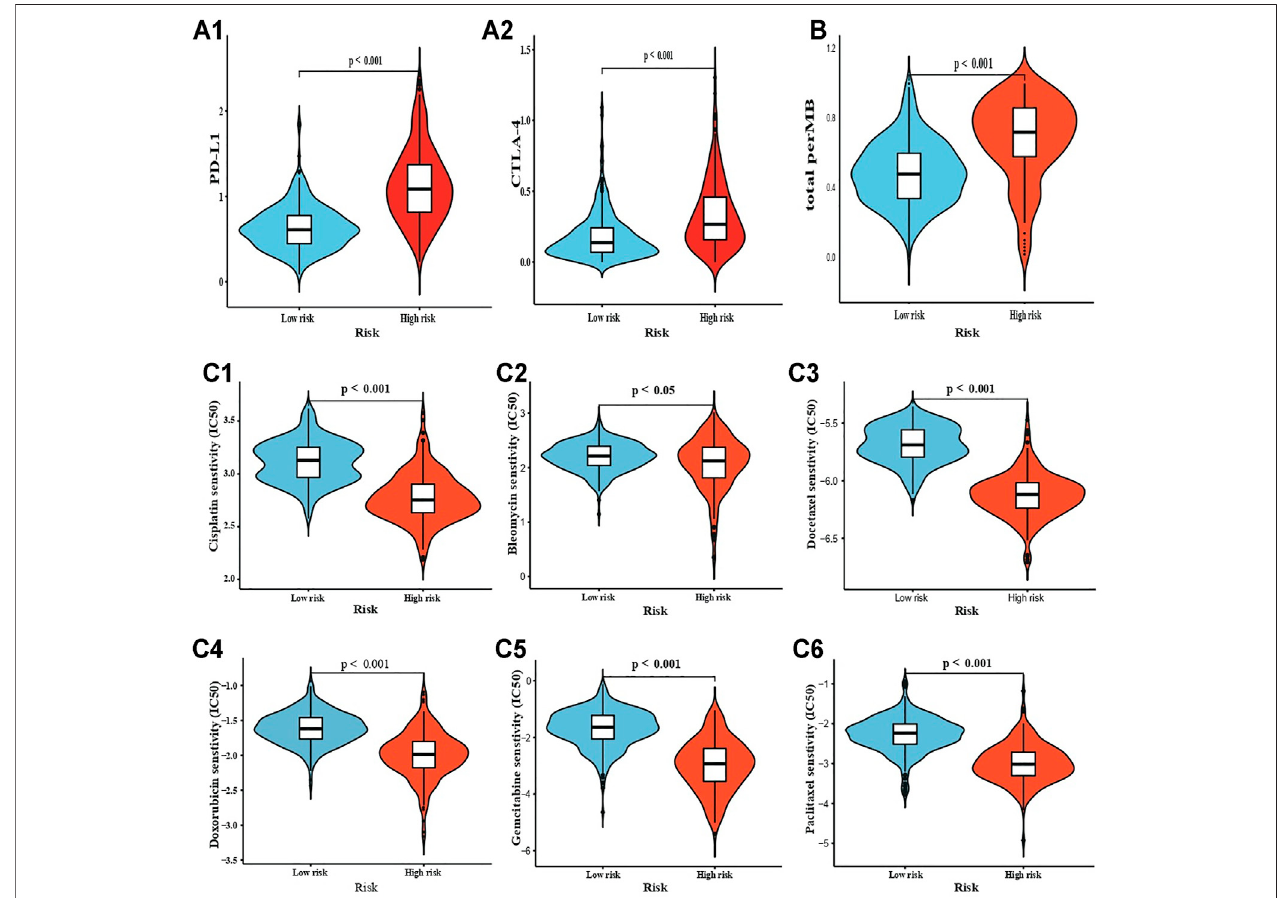
FIGURE 5 | Drug sensitivity estimation. (A1-A2) Immunotherapy sensitivity estimation by PD-L1 and CTLA-4, respectively; and (B) TMB. (C1-C6) chemotherapy IC50 estimation for Cisplatin, Bleomycin, Docetaxel, Doxorubicin, Gemcitabine, and Paclitaxel.